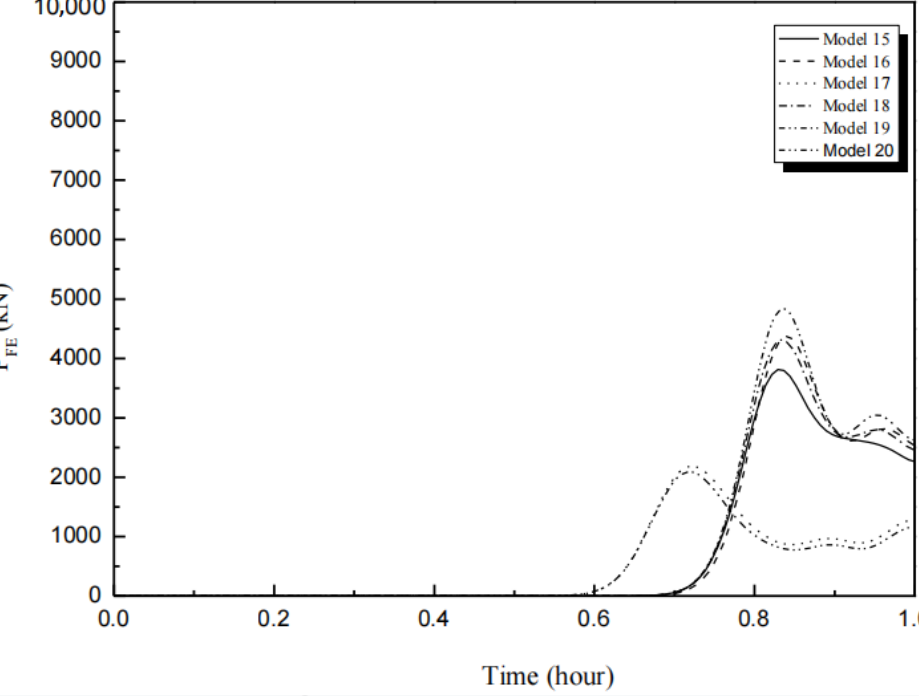
Figure 5. Axial strength versus time for model numbers 15–20.